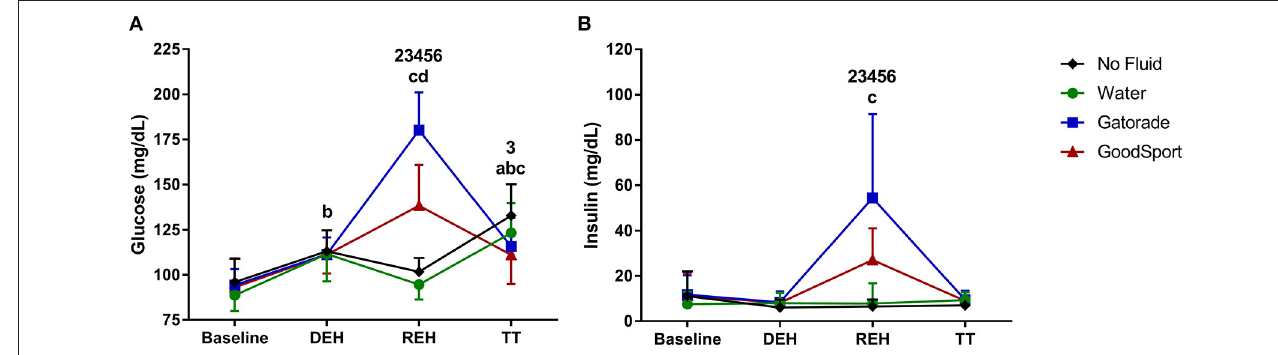
FIGURE 3 | (A) Glucose, and (B) insulin concentrations. Glucose and insulin concentrations were significantly higher in Gatorade (GAT) and GoodSport (GS) at REH compared to BASE and compared to no fluid and water. The increase in glucose and insulin concentrations in GAT was higher than in GS. 1, p < 0.05 WAT vs. NF; 2, p < 0.05 GAT vs. NF; 3, p < 0.05 GS vs. NF; 4, p < 0.05 GAT vs. WAT; 5, p < 0.05 GS vs. WAT; 6, p < 0.05 GS vs. GAT; a, p < 0.05 NF vs. BASE; b, p < 0.05 WAT vs. BASE; c, p < 0.05 GAT vs. BASE; d, p < 0.05 GS vs. BASE.